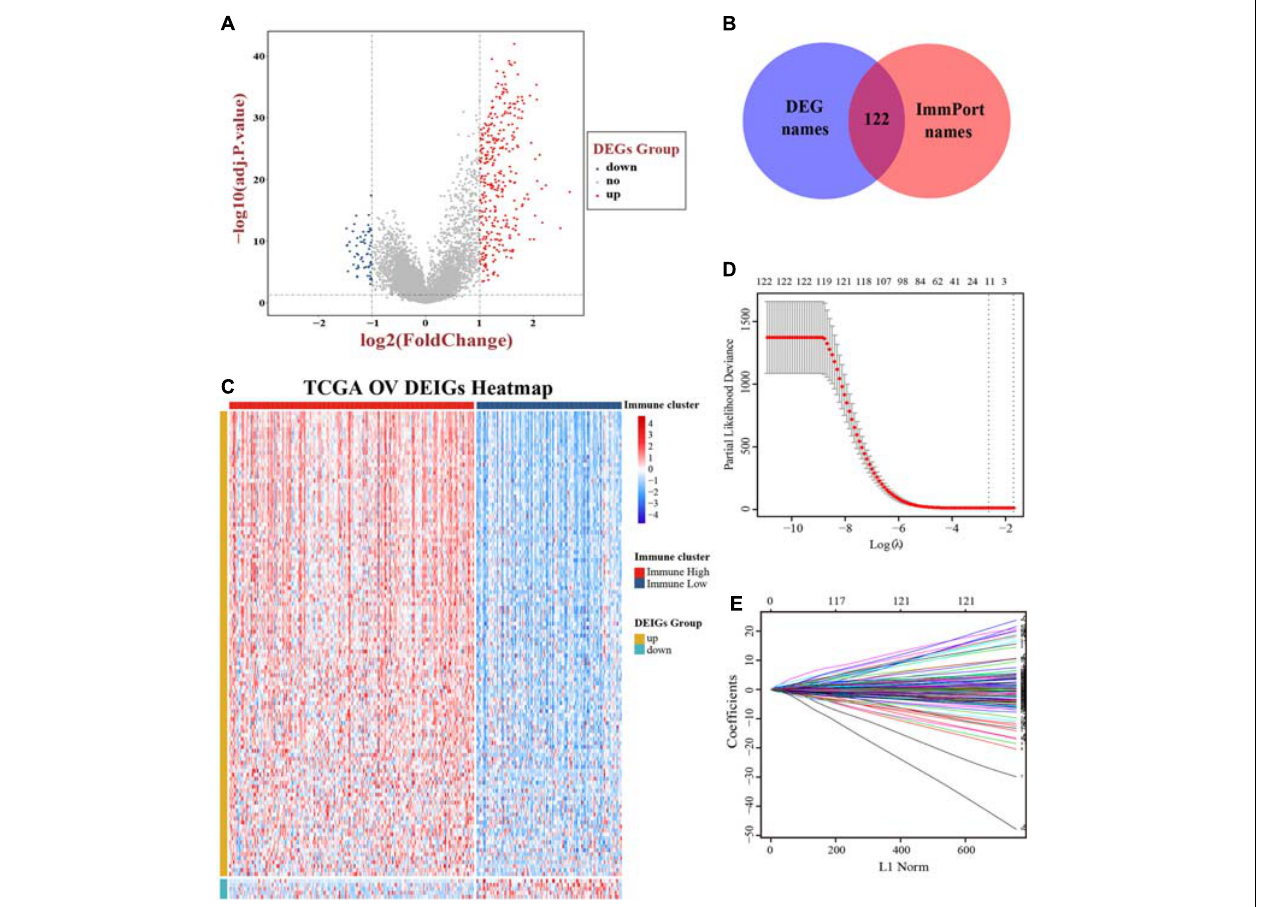
FIGURE 4 | Screening immune-related genes and construction of a prognostic model. (A) A volcano plot of all DEGs was shown combined with | log2-FC| and adjusted p value. (B) Extraction of immune-related genes from DEGs. (C) The landscape of expression pattern for all DEIGs between two immune clusters. Ten-fold cross-validation for tuning parameter selection (D) and coefficients extraction (E) in the LASSO Cox model. DEGs, differentially expressed genes; DEIGs, differentially expressed immune